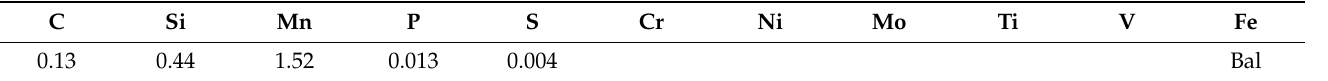
Table 1. Chemical composition of Q345 (mass fraction)